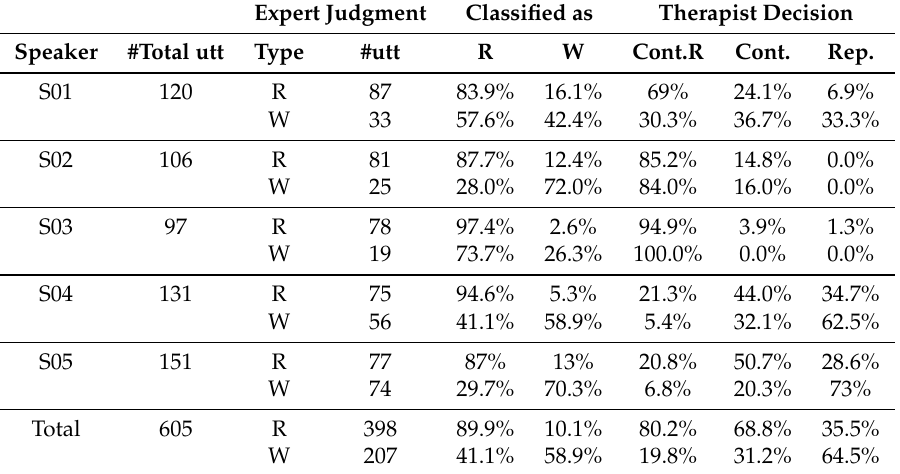
Table 5. Percentage of coincidence between therapist decision, classifier (SVM in case D) and prosody expert per speaker. Concerning the classifier, R represents the utterances classified as Right by the classifier and W represents the utterances classified as Wrong by the classifier. Each row percentage is relative to the number of each type of utterances of prosody expert evaluation. Expert